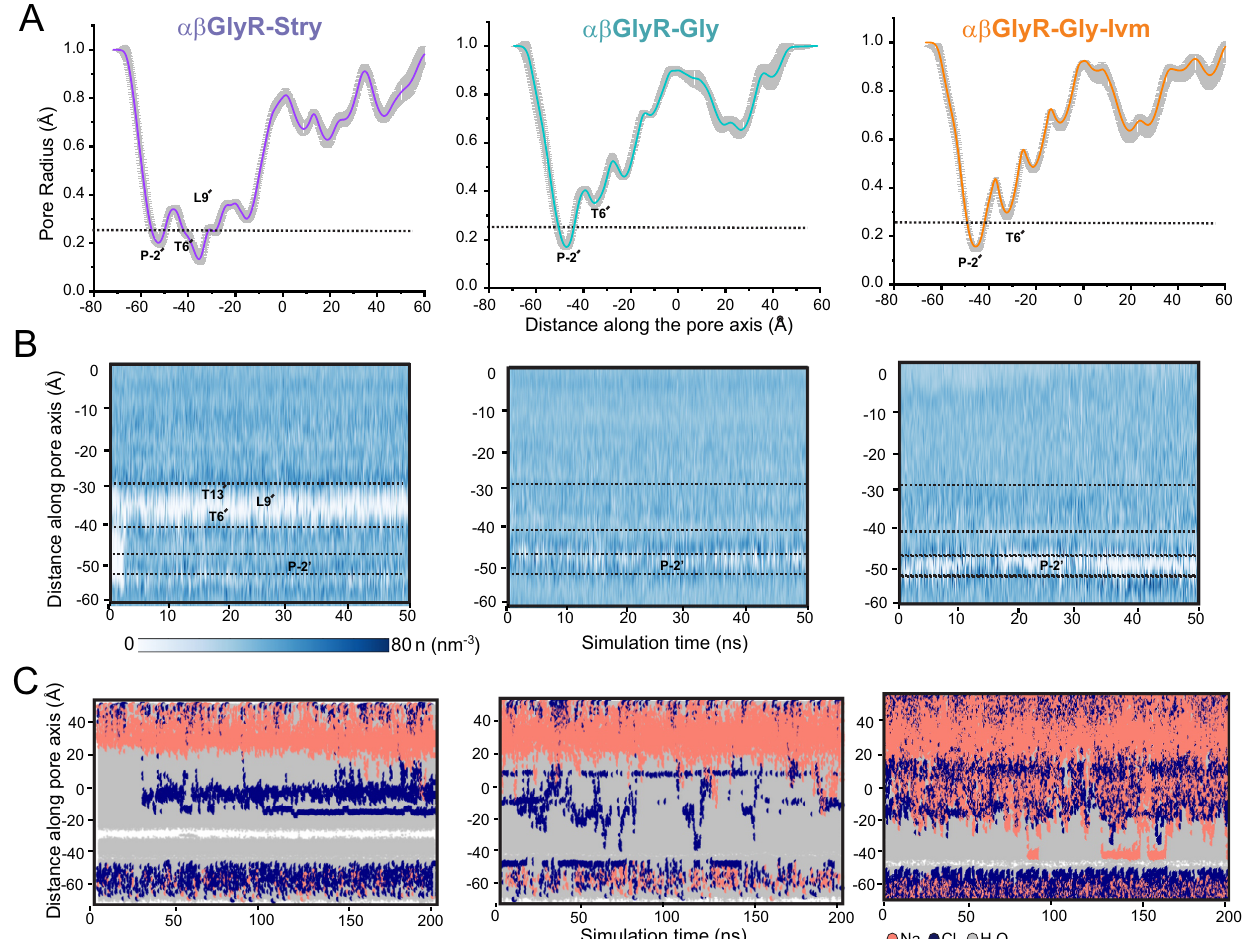
Fig. 3 | Molecular dynamics simulations of the αβ GlyR pore in different con- formational states. A Mean pore radius pro fi le and standard deviations averaged across 50ns equilibrium simulations for αβ GlyR-Stry (left), αβ GlyR-Gly (middle), and αβ GlyR-Gly-Ivm(right)alongthecentralporeaxis.Theone-standard-deviation range is shown as a gray band, and the thick line is the mean of a 50ns simulation. B Water density within the channel pore. Each discrete water molecule position is associated with a Gaussian distribution, and the sum of all Gaussians yields the density functionof wateralong the channel centerline. Bulkwater hasa density of 33nm − 3 . The time series of water density was calculated for 50ns equilibrium